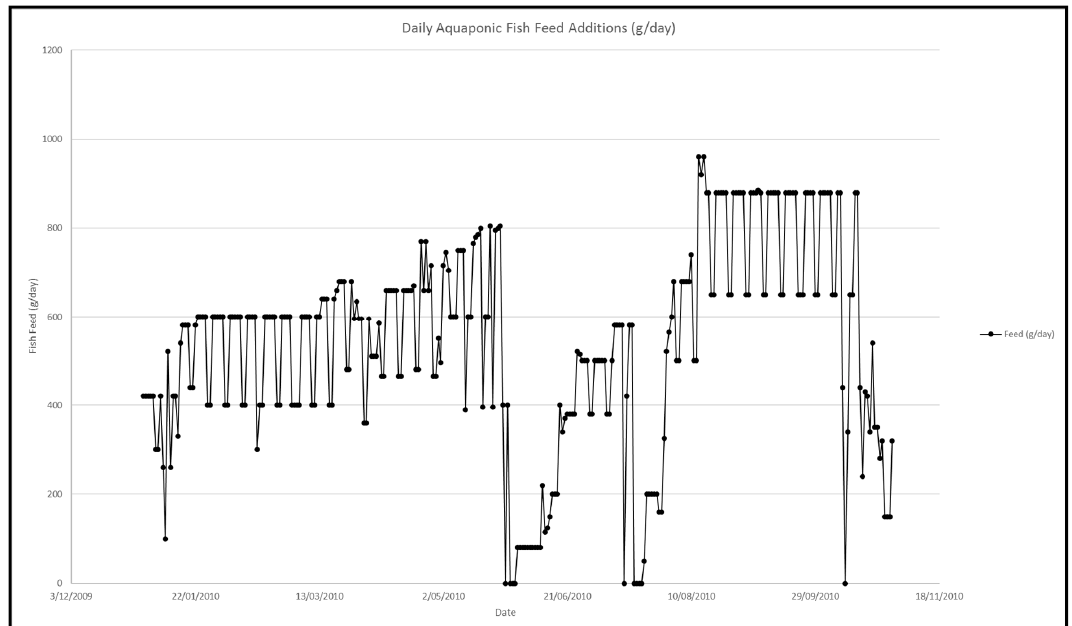
Figure 3. Daily aquaponic fish feed additions across the period of the trials.